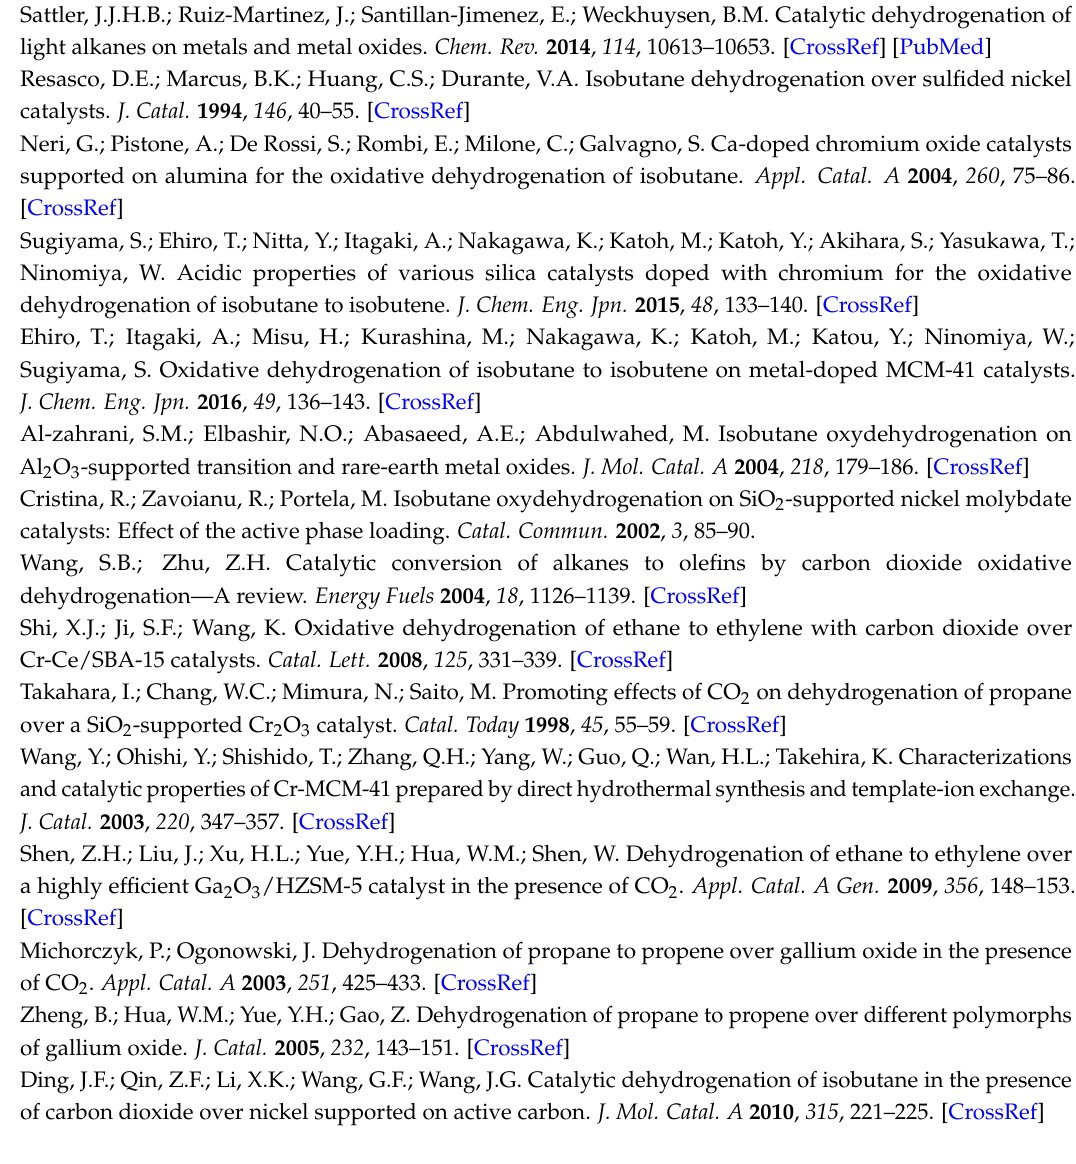
Figure S1: High-angle annular dark field (HAADF) images of ( a ) 3% V/SBA and ( b ) 7% V/SBA, Figure S2: Catalytic performance of 7% V/SBA for isobutane dehydrogenation at 570 ◦ C in the presence of CO 2 ( (cid:4) ) and in the absence of CO 2 ( •